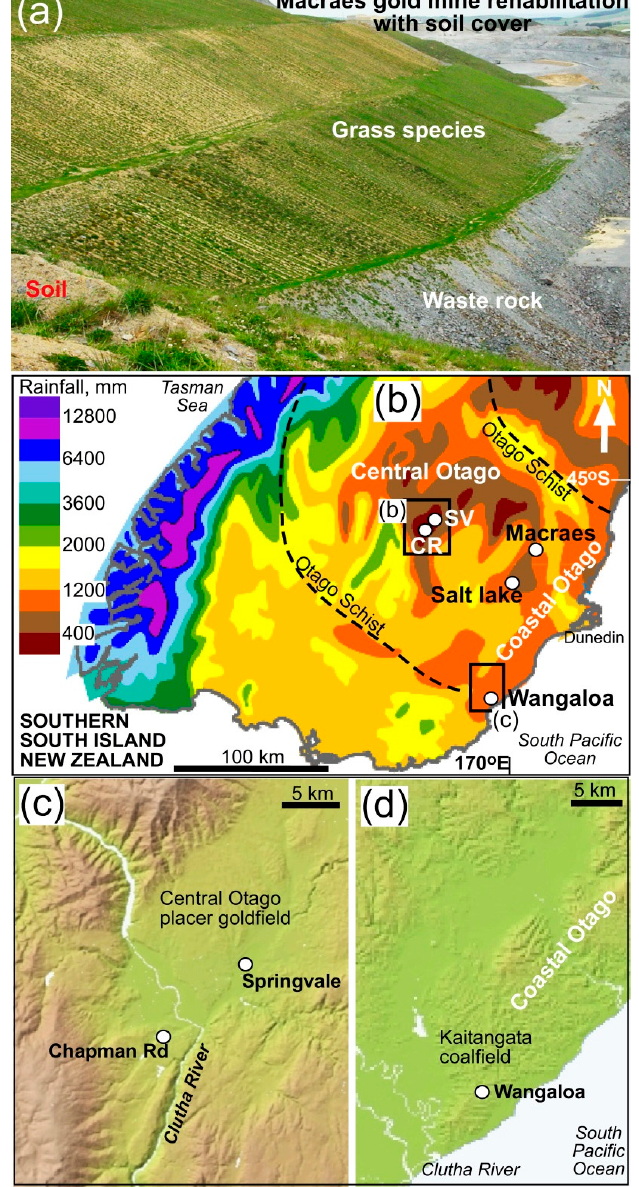
Figure 1. Regional setting for the mine sites outlined in this study. ( a ) Typical rehabilitation of schist debris at the modern Macraes orogenic gold mine (location in b ), leading to uniform vegetation and landscape. ( b ) Annual rainfall map of the southern South Island of New Zealand [19], showing the extreme rainfall gradients that lead to rain shadow effects to the east of the mountains on the western side of the island. Boundaries are indicated for the Otago Schist that forms the basement rocks and source for sediments at the sites studied. ( c ) Digital terrain model showing the topographic contexts for the historic Chapman Road and Springvale Placer gold mines. ( d ) Digital terrain model showing the topographic context for the historic Wangaloa coal